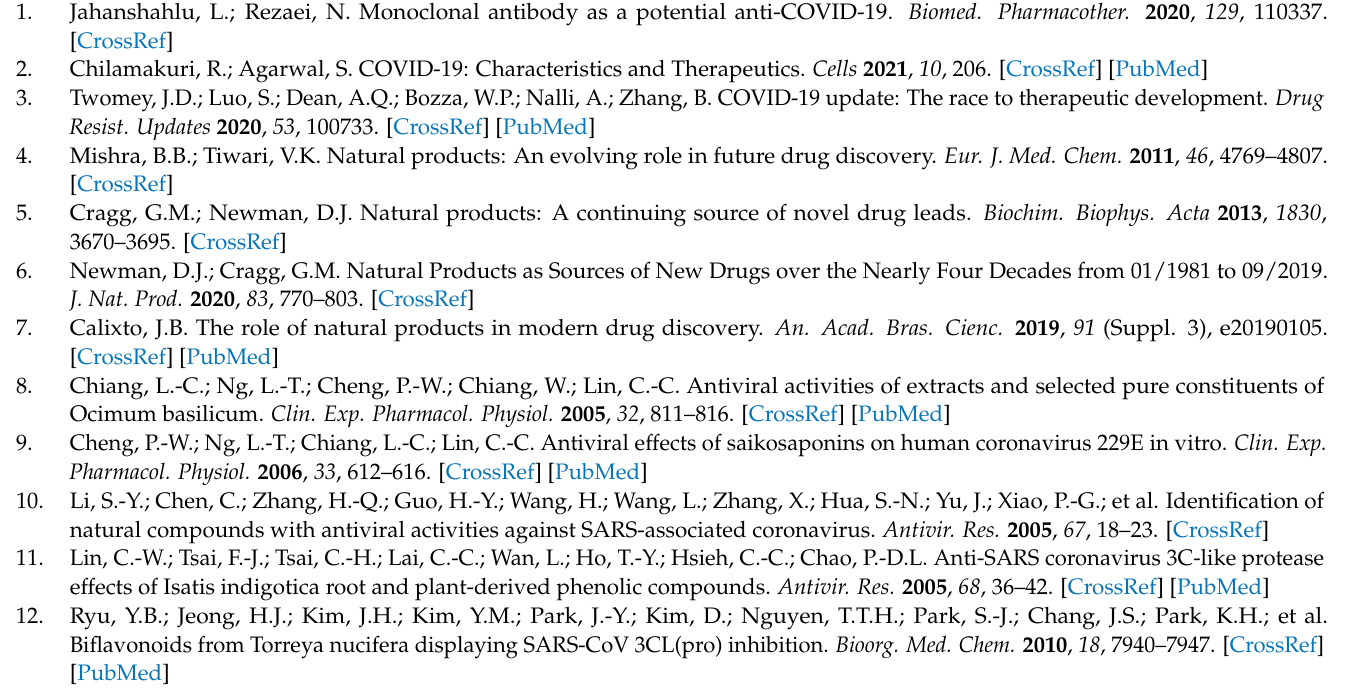
Complete table of docking simulations. Table S3: Simulation conditions applied for PBPK modelling. Table S4: Complete pharmacokinetic parameters for PBPK